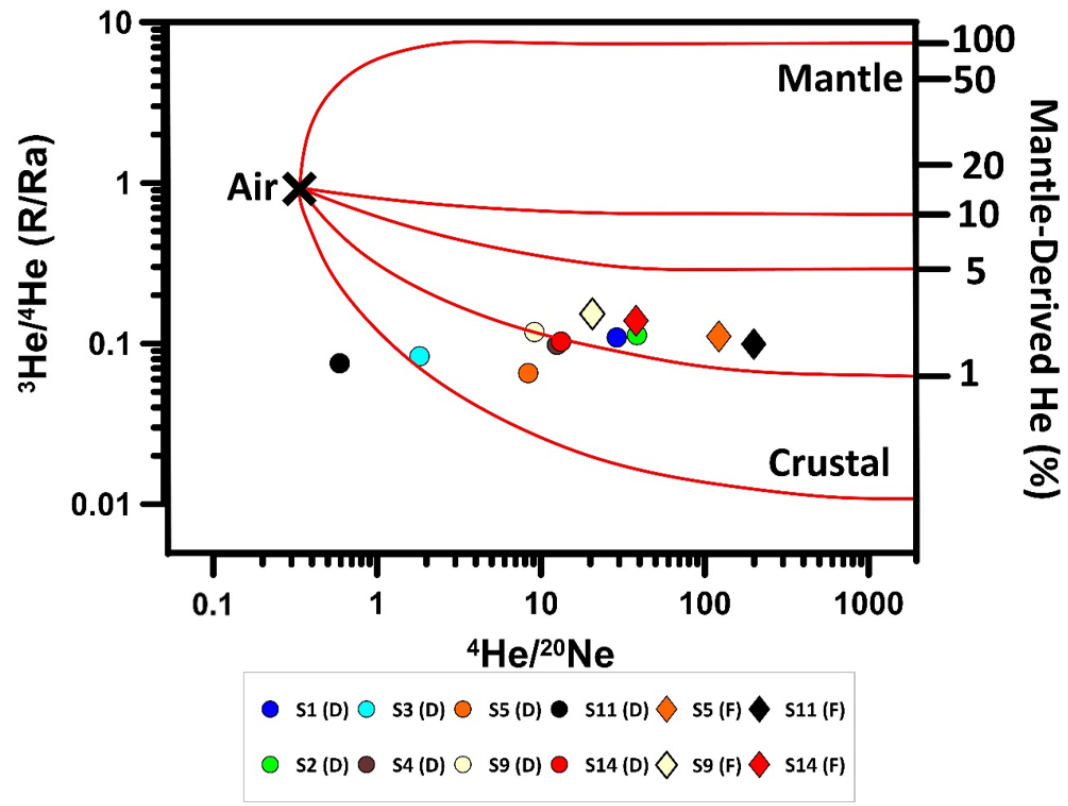
Figure 8 . Diagram of 3 He/ 4 He (R/Ra) versus 4 He/ 20 Ne ratios. Mixing lines between the atmosphere and upper mantle, and the atmosphere and crust were calculated using the end members: air ( 3 He/ 4 He = 1.4 × 10 −6 , 4 He/ 20 Ne = 0.318) [86], upper mantle ( 3 He/ 4 He = 12 × 10 −6 , 4 He/ 20 Ne = 100,000) [132], and old continental crust ( 3 He/ 4 He = 0.02 × 10 −6 , 4 He/ 20 Ne = 100,000) [131]. Samples of dissolved and free gases are named (D) and (F), respectively. See Figure 1 for spring location.